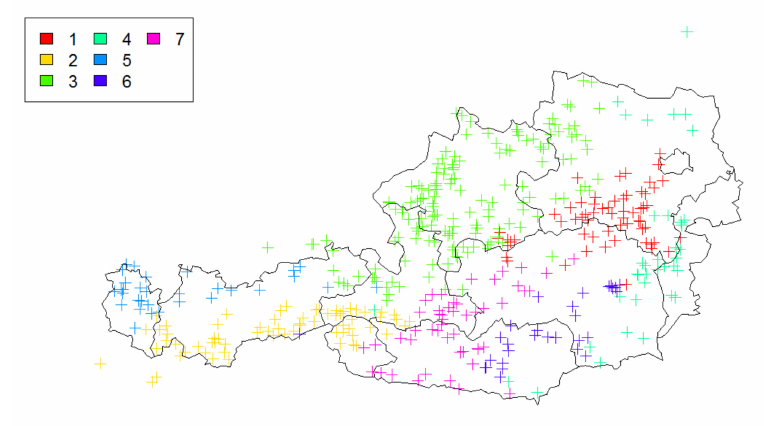
Figure 1. Clusters of measurement